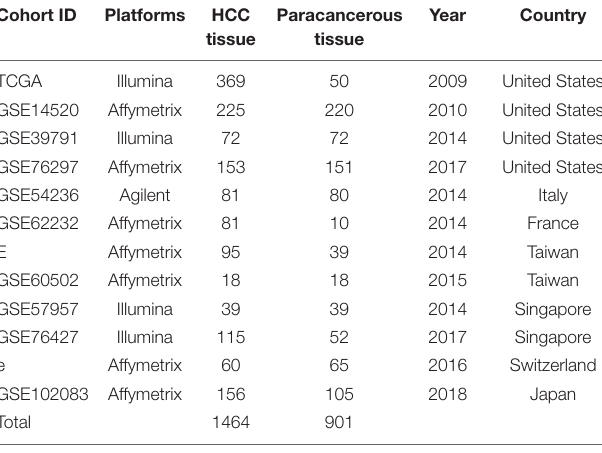
TABLE 1 | HCC expression profile cohorts used in this